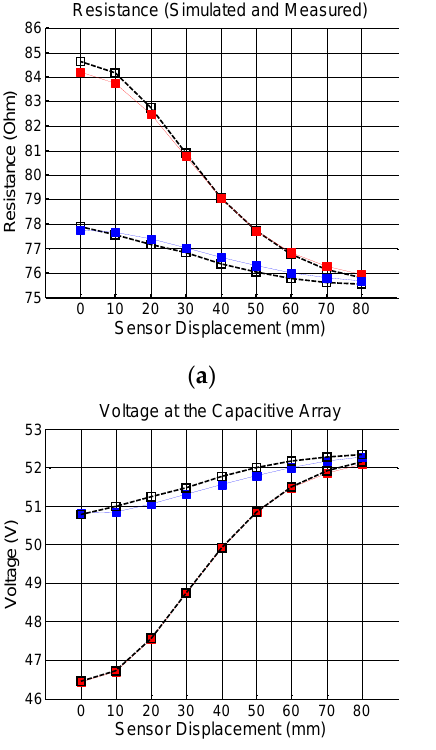
( c ) Figure 6. Induced current in the steel bar represented by the red arrows. ( a ) Perspective view; ( b ) Top view; ( c ) side view. These figures are very interesting to understand the behavior of the field quantities involved. However, to evaluate if this sensor will produce the expected results other variables should be analyzed, such as the effective resistance and inductance of the winding, changes in the phase angle of the current in the sensor, and the voltage drop at the capacitive array. COMSOL Multiphysics was